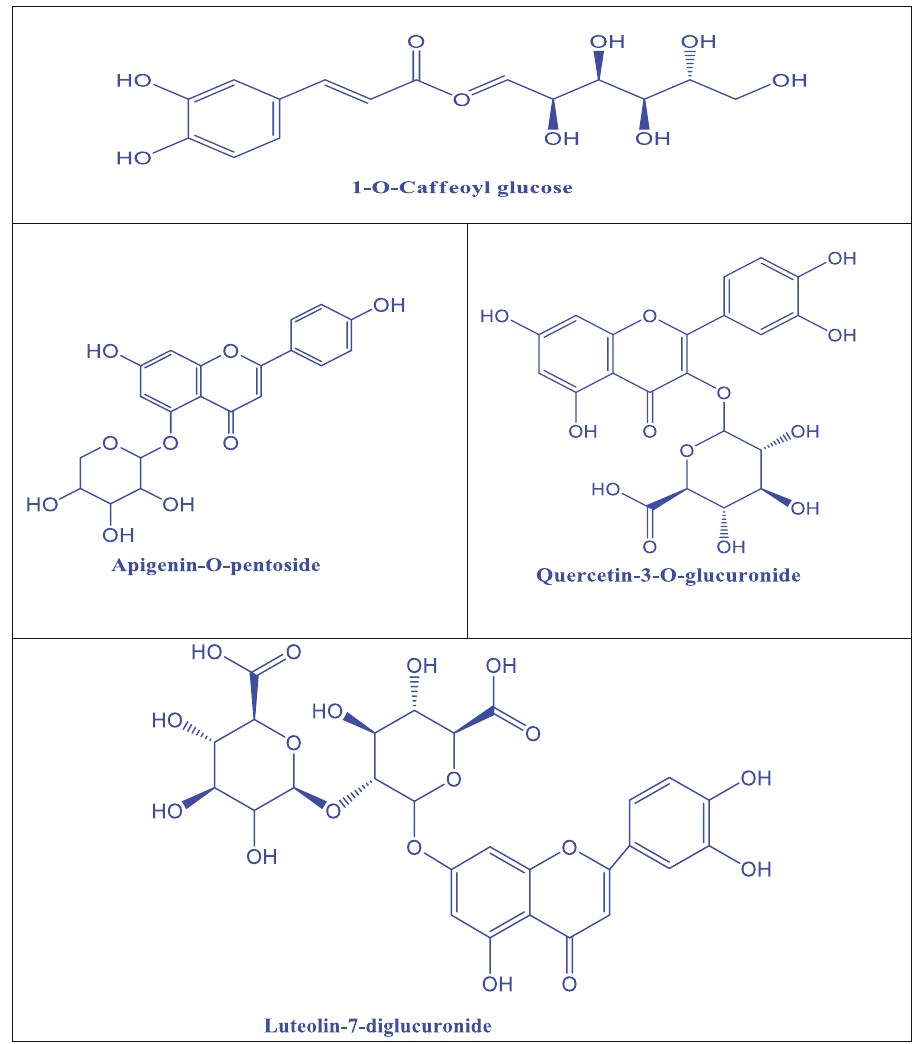
Figure 2: Chemical structure of compounds in the polyphenol - rich fraction from the leaves of Withania adpressa Coss. ex